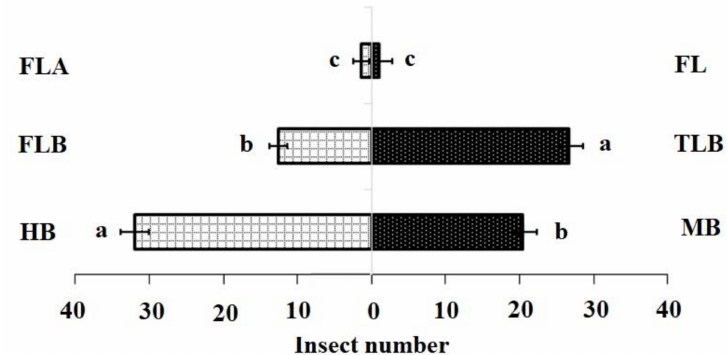
Figure 1. Olfactory responses of Plutella xylostella adults to natural volatiles. Bars represent the mean ( ± SE) response of adult female (compared using the χ 2 test) exposed to natural volatiles from Barbarea vulgaris plants. Di ff erent letters indicate di ff erences between two treatments at p < 0.05. HB, healthy B. vulgaris ; FLB, first instar larvae feeding on B. vulgaris ; TLB, third instar larvae feeding on B. vulgaris ; MB, mechanically damaged B. vulgaris ; FLA, first instar larvae feeding on artificial diet; FL, first instar larvae only